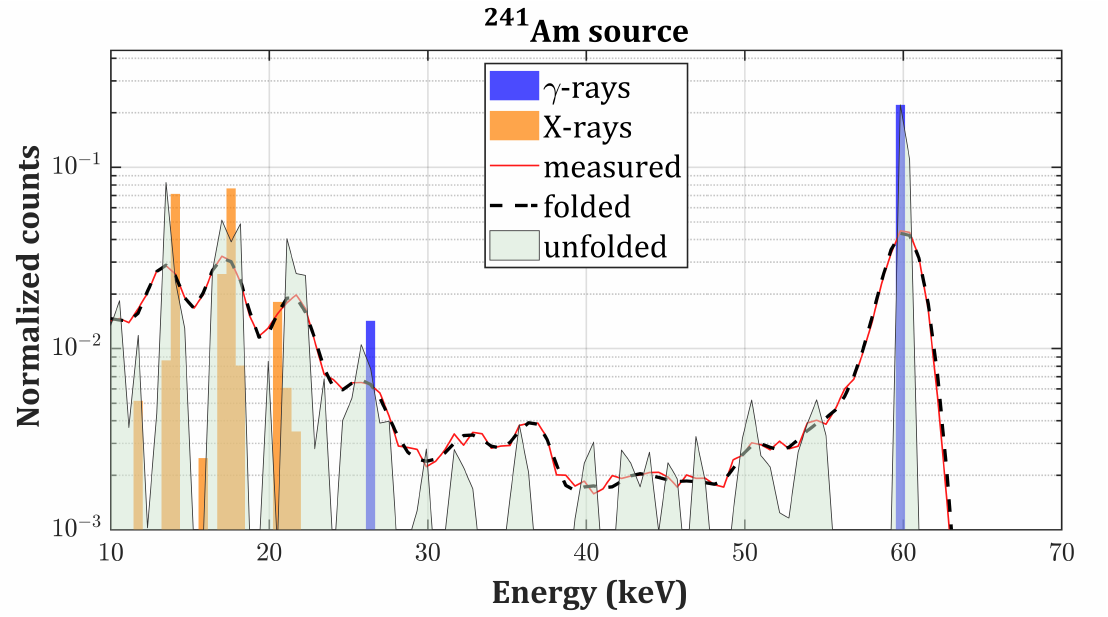
Figure 8. 241 Am unfolded spectrum (gray curve) compared to the measured spectrum (red curve), the folded spectrum (black dashed curve) and the tabulated intensities of the γ -emissions (blue bars) and X -emissions (orange bars) of 241 Am on a logarithmic